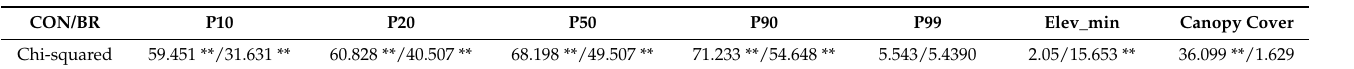
Table 9. LiDAR metrics for the Kruskal–Wallis test results for broadleaf and coniferous forests at different scanning